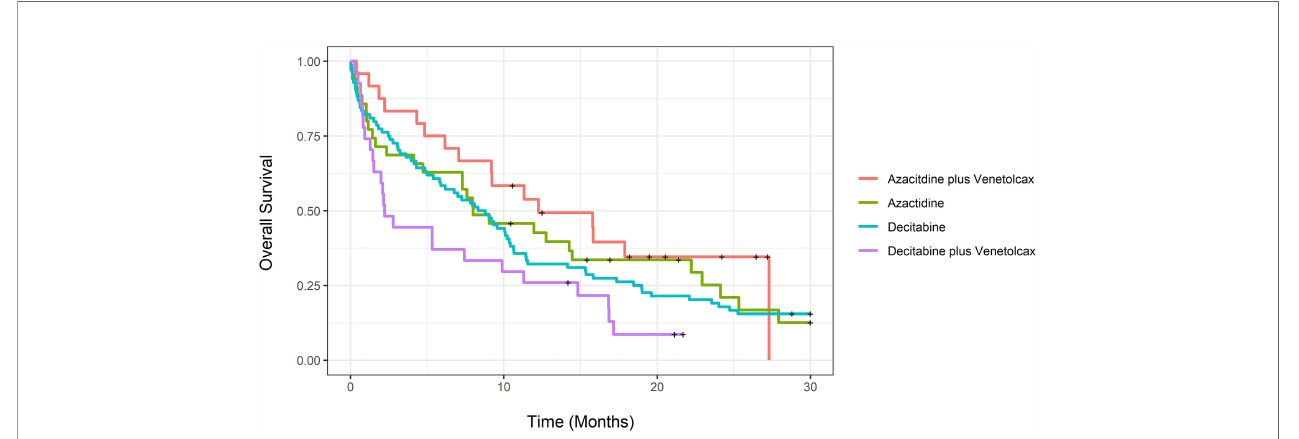
CCR, OS, EFS and TRM